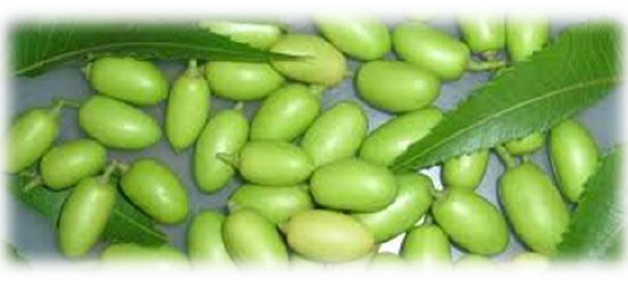
Figure 3: Neem bark